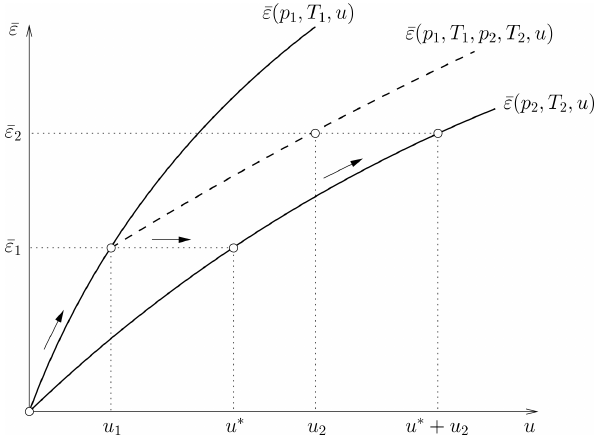
Figure 3. Illustration of the EGA method. For the first segment of a ray path, the EGA method will apply the emissivity curve ε(p 1 ,T 1 ,u) to determine the spectral mean segment emissivity. For the second segment, the EGA method will locate the pseudo- column amount u ∗ on ε(p 2 ,T 2 ,u) and calculate the emissivity of the extended path based on the total column amount u ∗ + u 2 . This approach will be followed along the entire